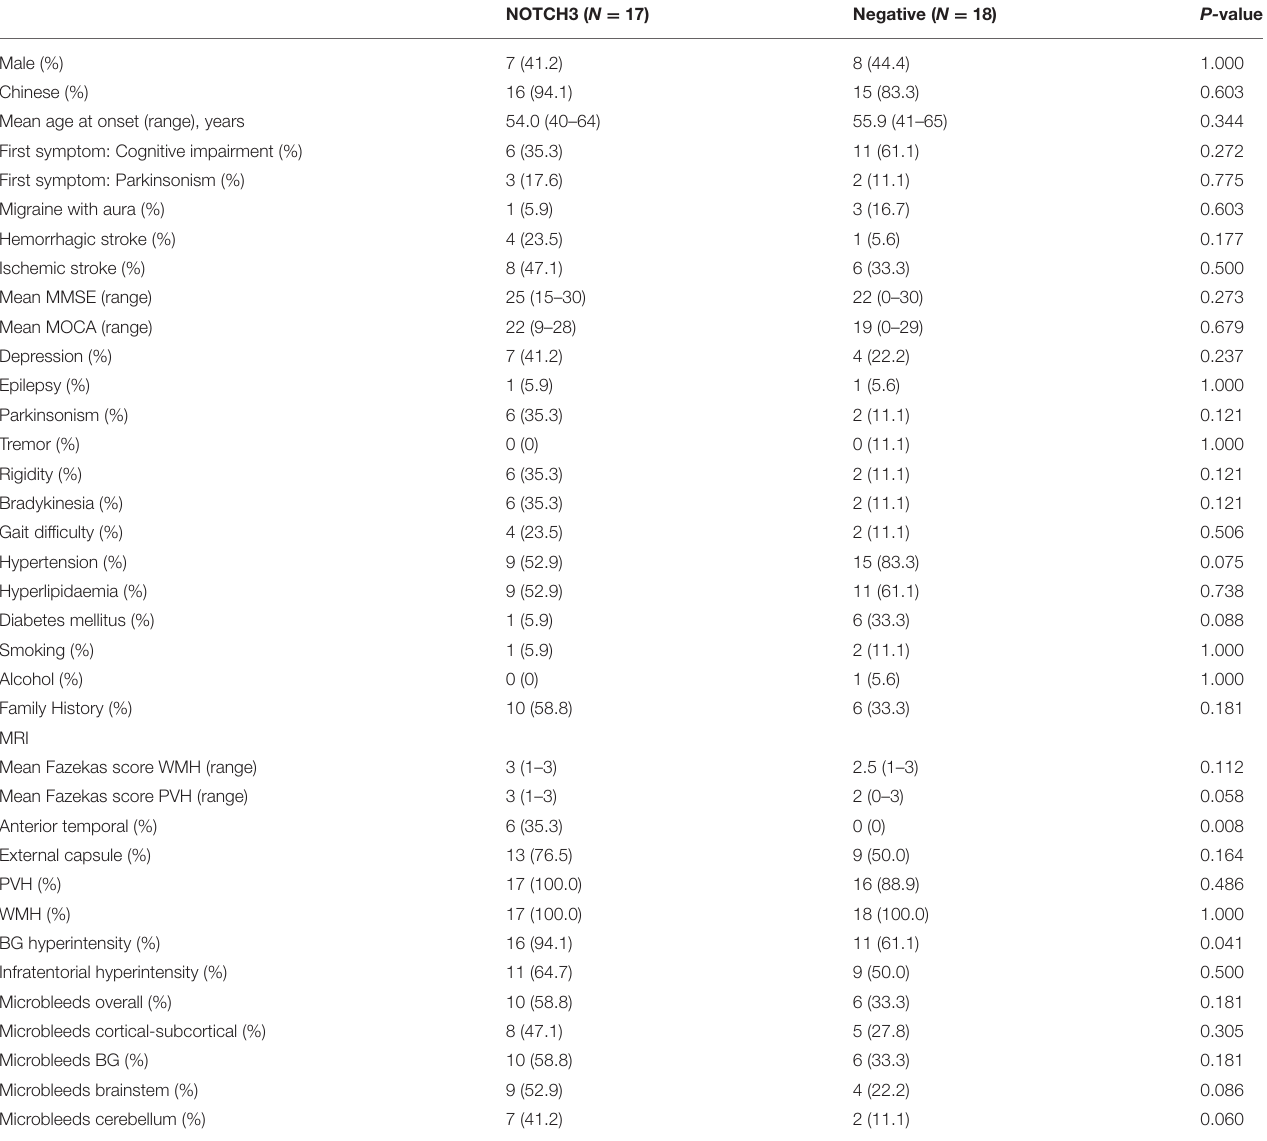
TABLE 3 | Comparison between VCI-SVD patients with pathogenic NOTCH3 variants with VCI-SVD patients without pathogenic